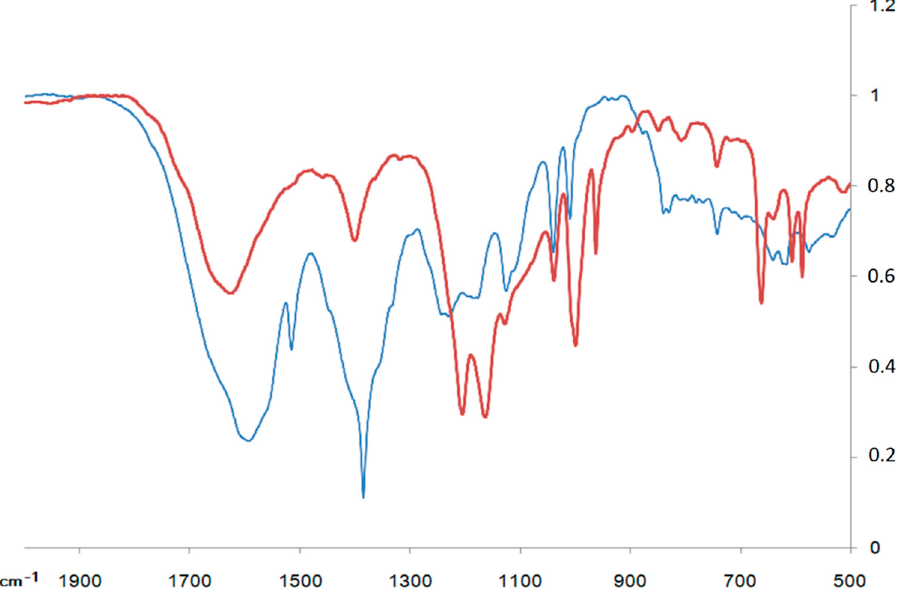
Figure 8. IR spectra of complex I (blue line) and Cu-[I-Cu] 6 (red line) in KBr discs .